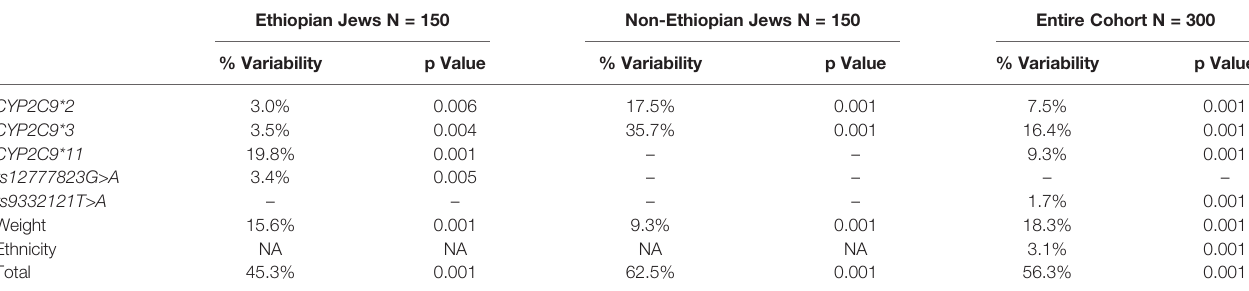
TABLE 8 | Multiple regression model for the prediction of Log 10 PMR24/24 among Ethiopian Jews, non-Ethiopian Jews, and the entire cohort of both Ethiopian and non-Ethiopian